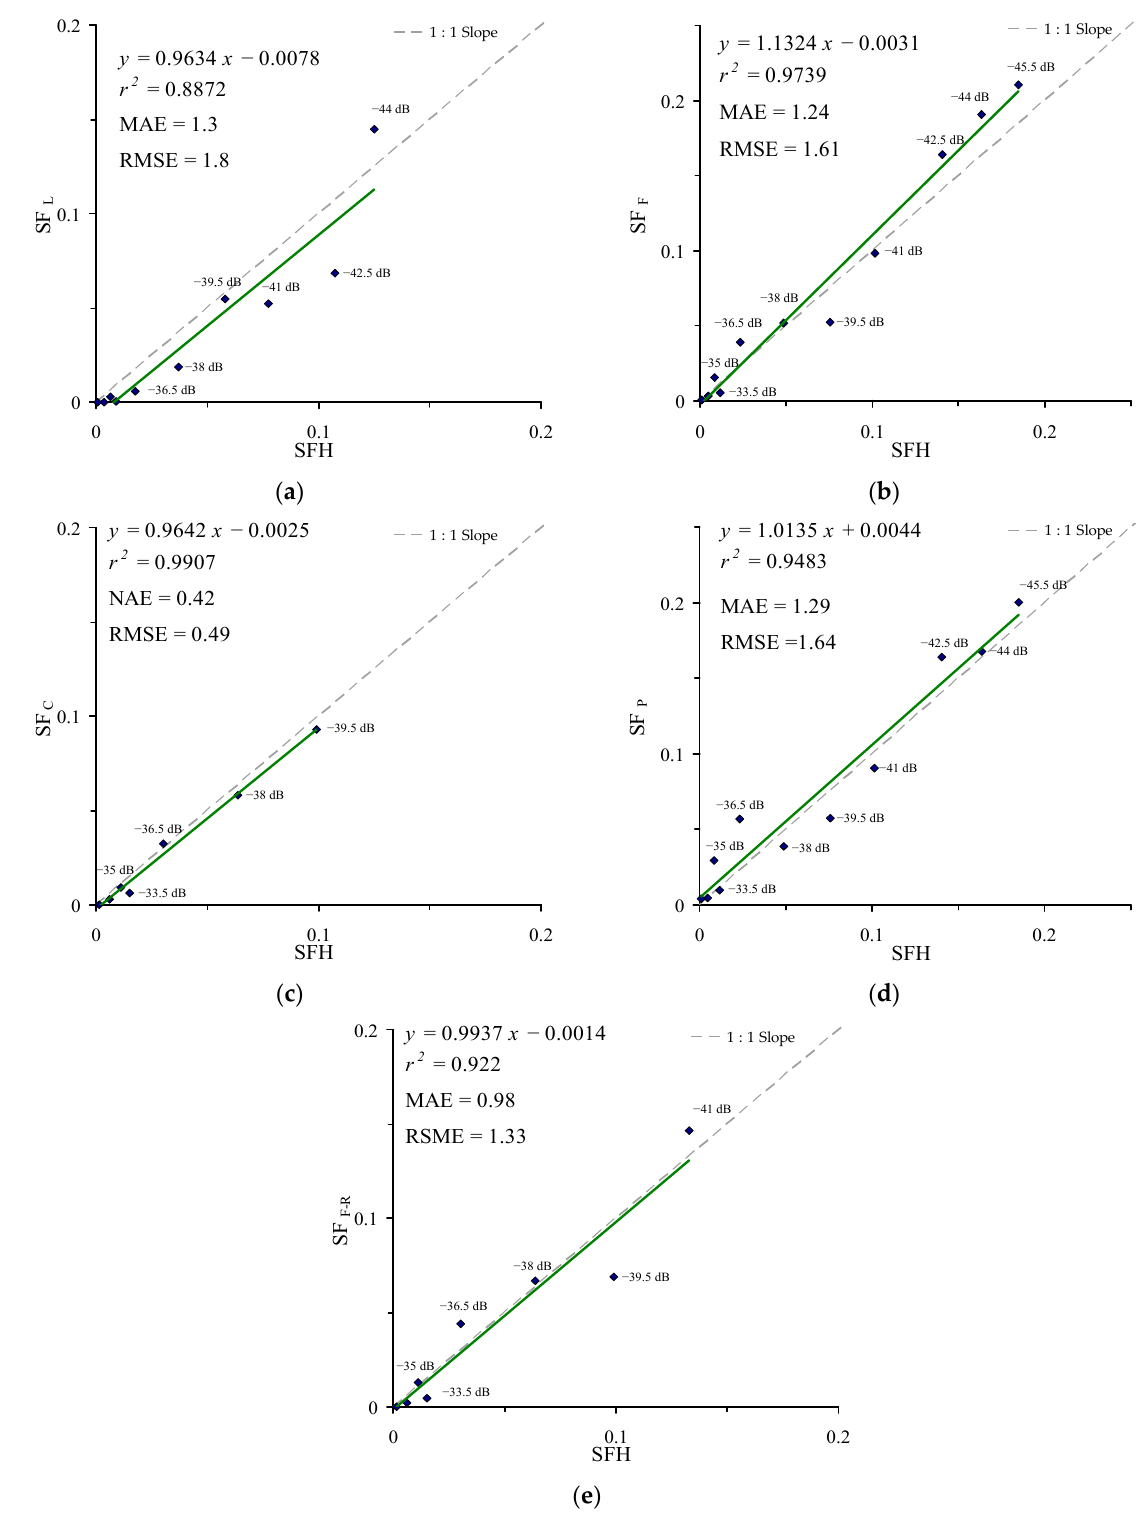
Figure 7. Opportunities to optimize the regression (marked with a green line) between the relative proportion of fish caught with Nordic multimesh gillnets (SF) that have been assigned to overall length ( TL ) classes according to various TS – TL relationships and the relative proportion of hydro- acoustically identified fish ( SFH ). The optimization consisted in narrowing down the data subsets by removing classes based on the stepwise NSE analysis (search for the maximum NSE ; cf. Table 3). ( a – e ) as in Figure 4.